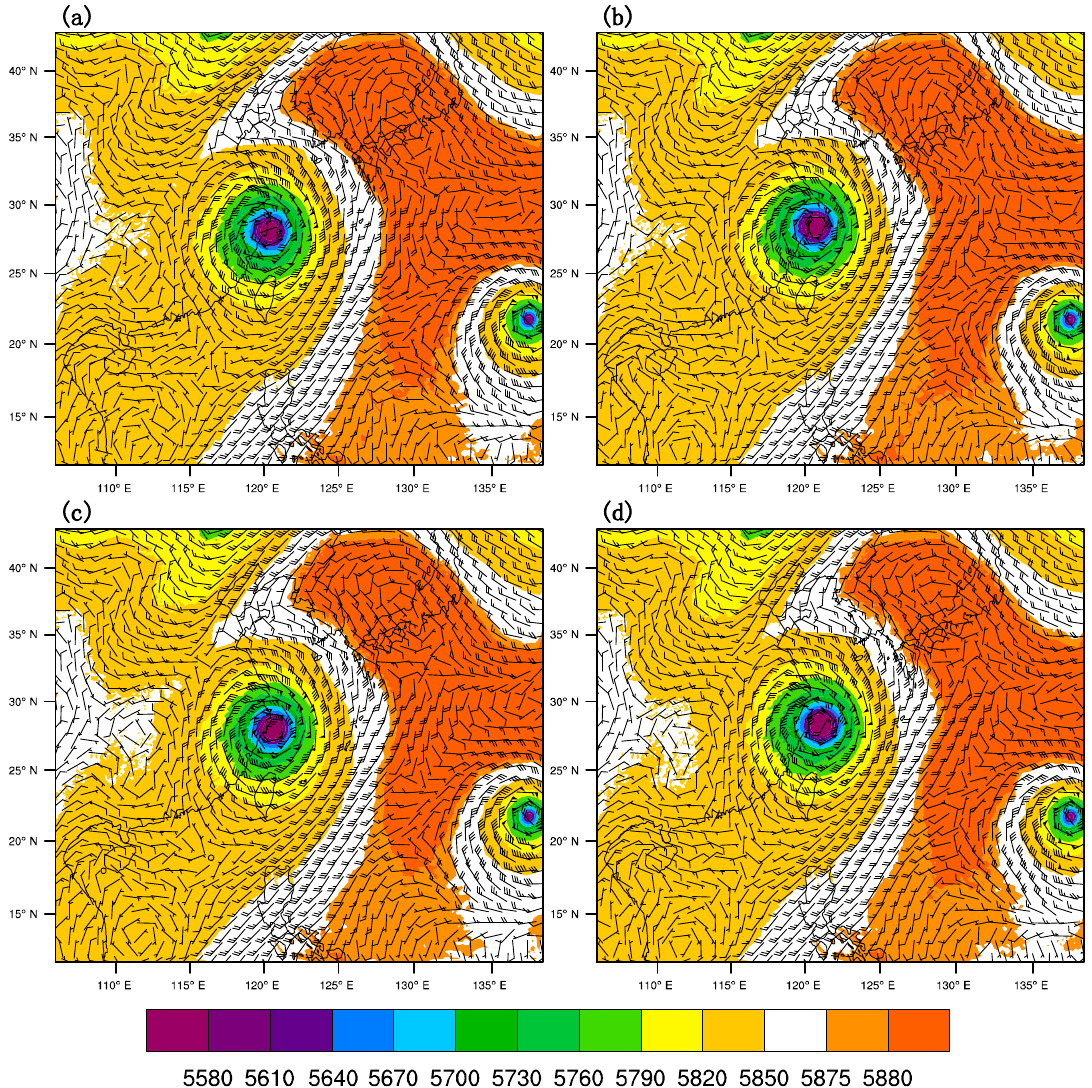
Figure 8. Forecast field with a geopotential height of 500 hPa (filled colors, unit: gpm) and wind (wind bars, unit: kts) of ( a ) GTS_DA, ( b ) AMSU-A_DA, ( c ) AIRS_DA, and ( d ) AMSU-A + AIRS_DA at 0000 UTC on 11 July 2015.